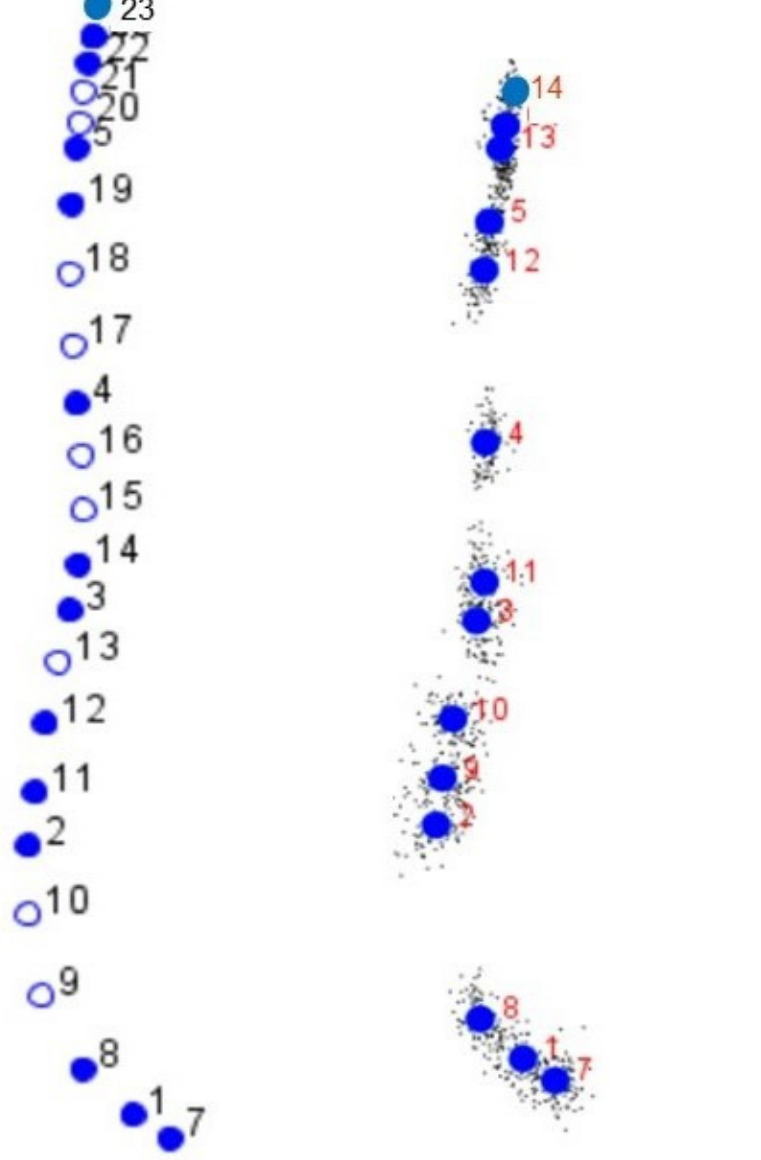
Figure 2. ( Left ): Set of the 14 semi-landmarks (empty dots) and semi-landmarks (filled dots), which were ultimately used for the study of the development of the cephalic profile in the Purebred Arabian horse and its F1 crosses. ( Right ): Semi-landmarks (filled dots) with small black dots on the right indicate the individual scattering for each semi-landmark.